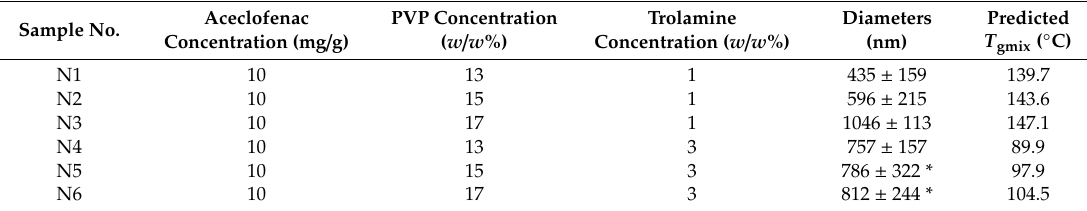
Table 1. Composition of viscous polymeric solutions used for the preparation of nanofibers, diameters of the obtained fibers and estimation of the glass transition temperatures. Sample